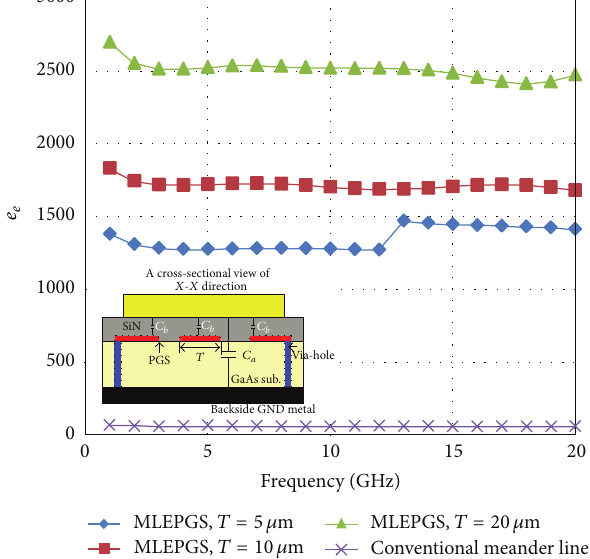
Figure 4: Measured attenuation constant of the MLEPGS.